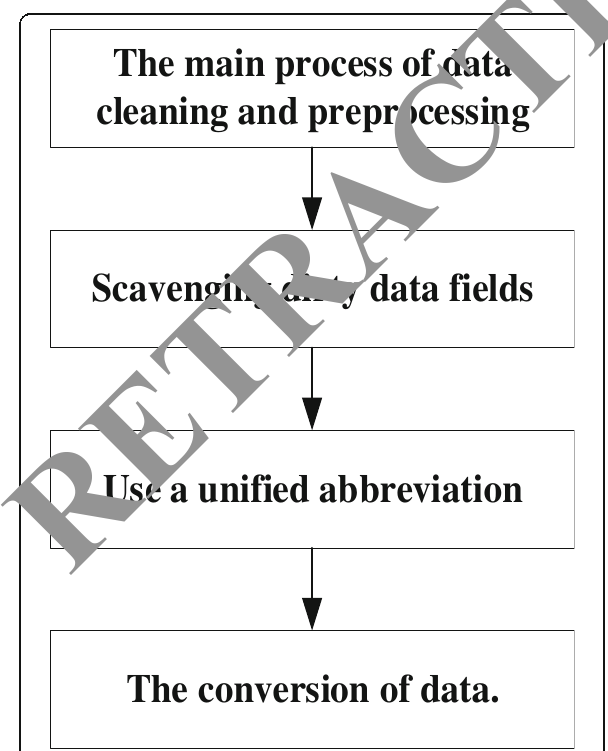
Fig. 3 The main process of data cleaning and preprocessing